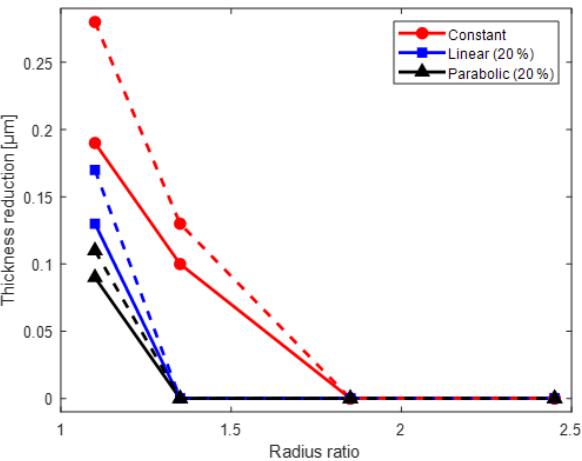
Figure 5. Coated layer measurement system: ( a ) interferometer; ( b ) scanning electron microscope (SEM); and ( c ) polarizing microscope.